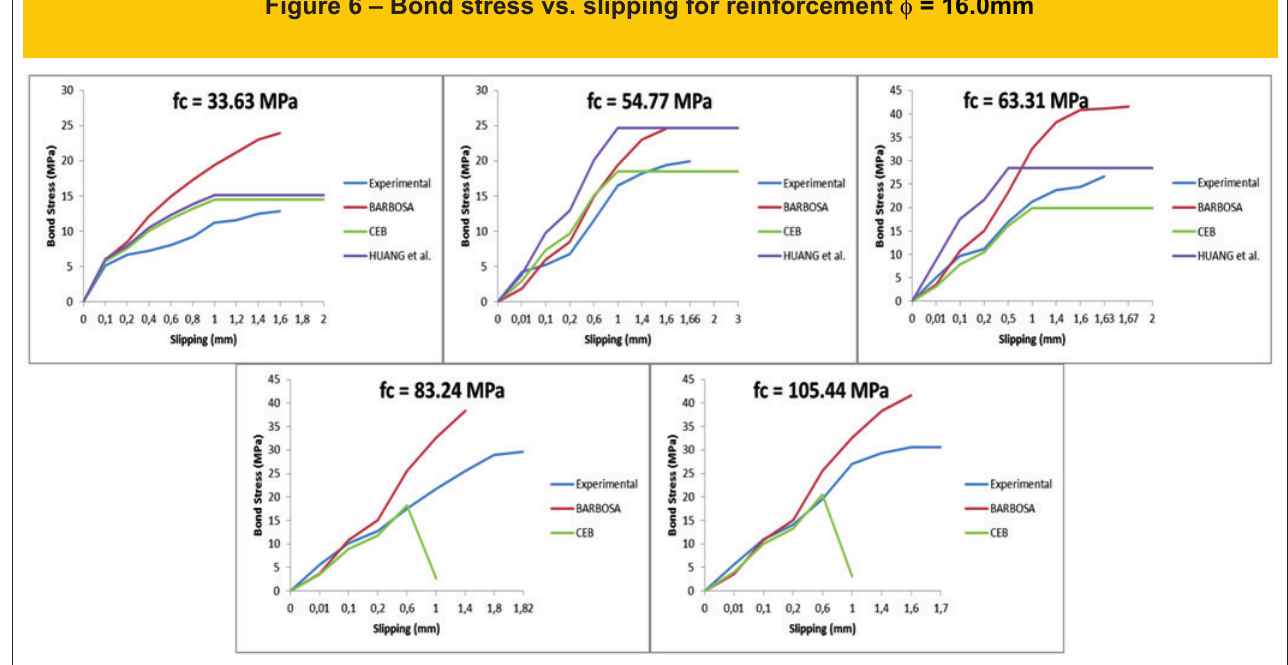
Figure 6 – Bond stress vs. slipping for reinforcement f =